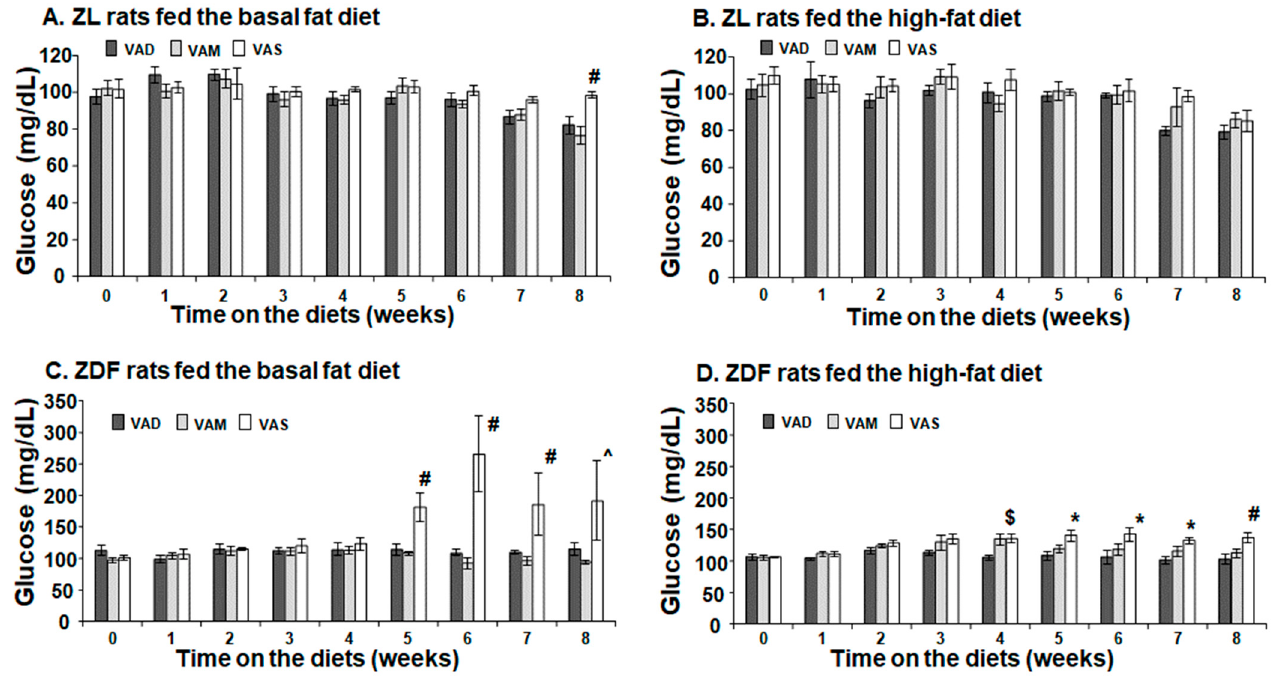
Figure 3. Peripheral blood glucose levels of ZL or ZDF rats fed a VAD, VAM or VAS diet with BF or HF content for 8 Weeks. The PBG levels from rat tail tips were measured weekly. Data are expressed as mean ± SEM; n = 5–6 per group; * For VAD < VAS; ˆ for VAM < VAS: # for VAD/VAM < VAS; $ for VAD < VAM/VAS; all p <